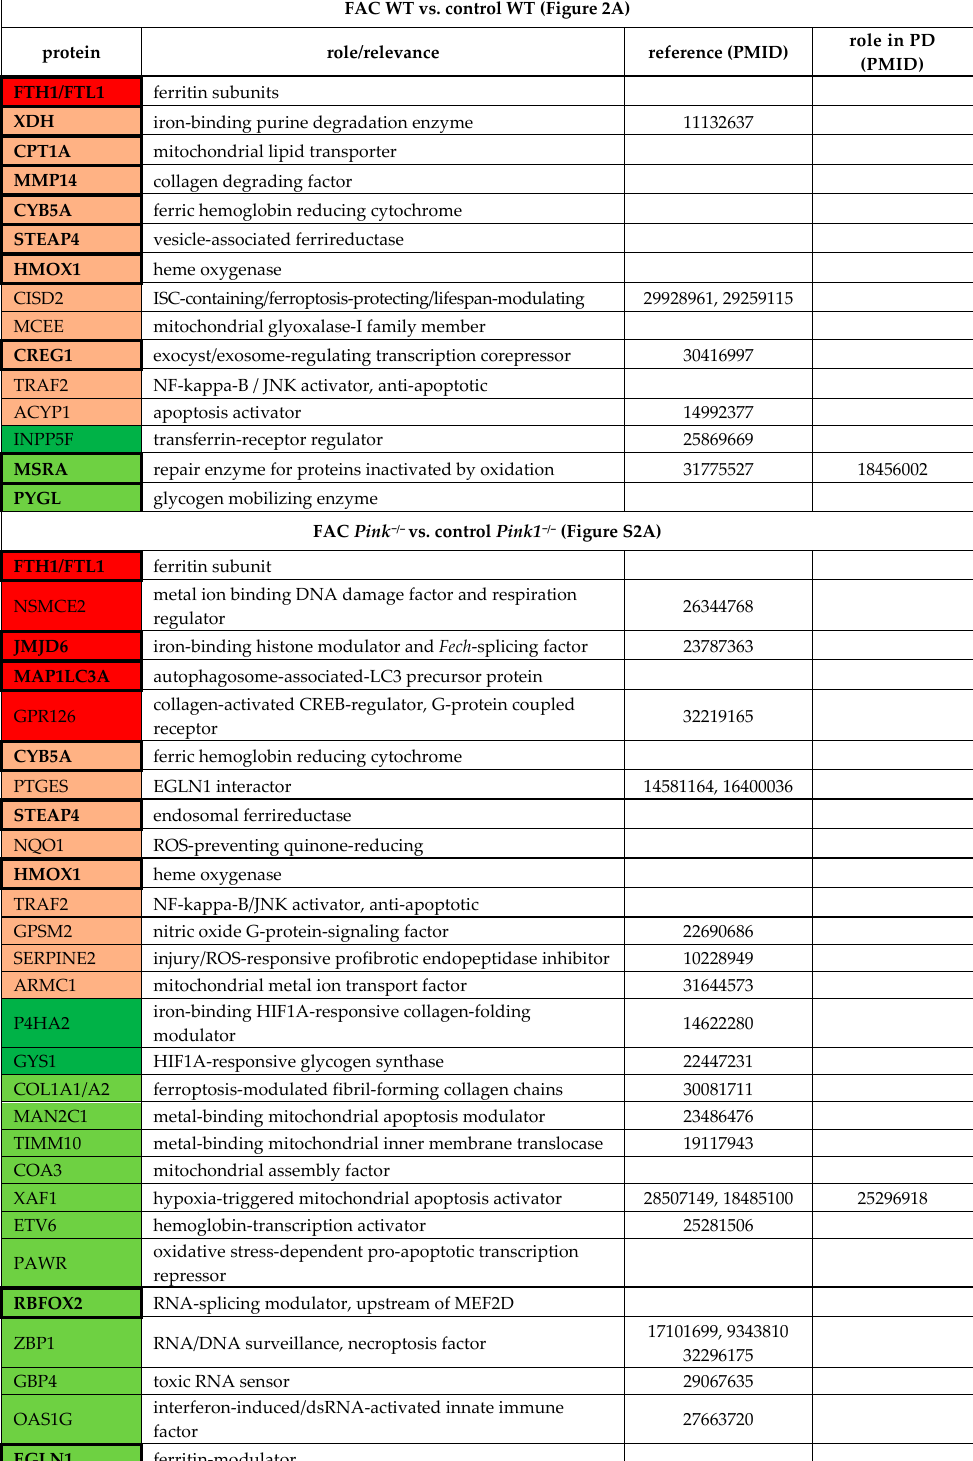
Table 1. FAC e ff ects. Overview of selected significantly changed factors in the global proteome of MEF, comparing FAC WT vs. control WT, and FAC Pink1 − / − vs. control Pink1 − / − , listing their respective roles and literature references (PubMedIDs), and highlighting special relevance for Parkinson’s disease (PD). Upregulations are shown with dark red (FDR > 0.05) and light red ( p > 0.05), whereas downregulations are marked with dark green (FDR > 0.05) and light green ( p > 0.05). Factors that show converse regulation after iron overload versus iron depletion and thus appear in several tables are marked with bold fonts. Factors with dysregulation in diverse conditions are emphasized by increased table cell Cells 2020 , 9 , x 5 of 47 border thickness. For details, see Figure 2 and Supplementary Table S1. FAC WT vs. control WT (Figure